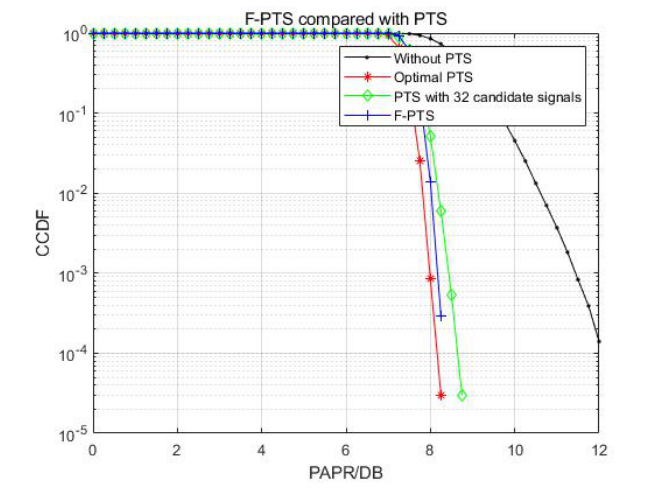
Figure 10. The comparison between performance of PTS and F-PTS.